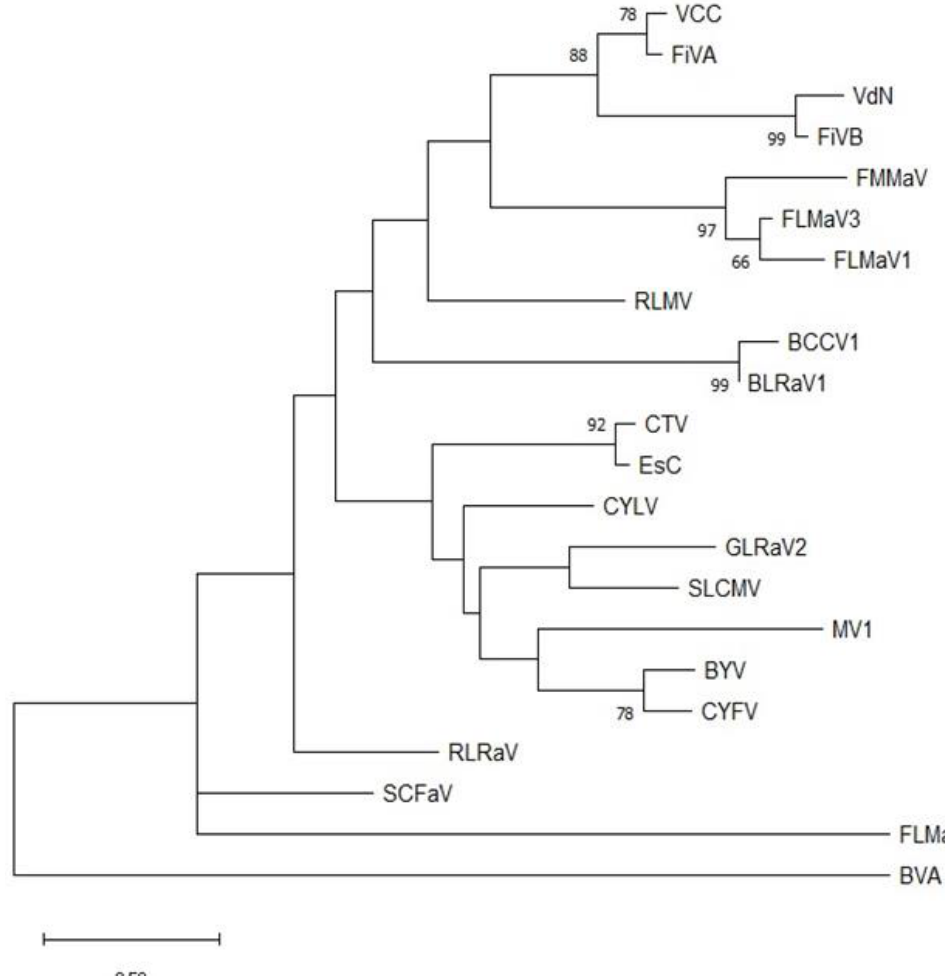
Figure 2. Maximum likelihood phylogenetic reconstruction of the 5’ portion of 72 amino acids in the HSP70h protein of selected closterovirids. The ampeloviruses FLMaV2 and BVA, unassigned species in the family Closteroviridae , represent the outgroups. Bootstrap values higher than 60% on supported nodes and a distance bar are shown. Used accession numbers for the virus proteins are: